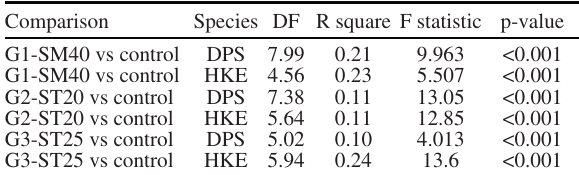
Table 2. – GAMM parameters from comparison of trawl net equipped with JTED (test gear) with trawl net without JTED (con- trol gear) with catch in number per hour. G1-SM40, JTED covered with a net of 40-mm square mesh; G2-ST20, JTED with steel bars spaced 20 mm; G3-ST25, JTED with steel bars spaced 25 mm.